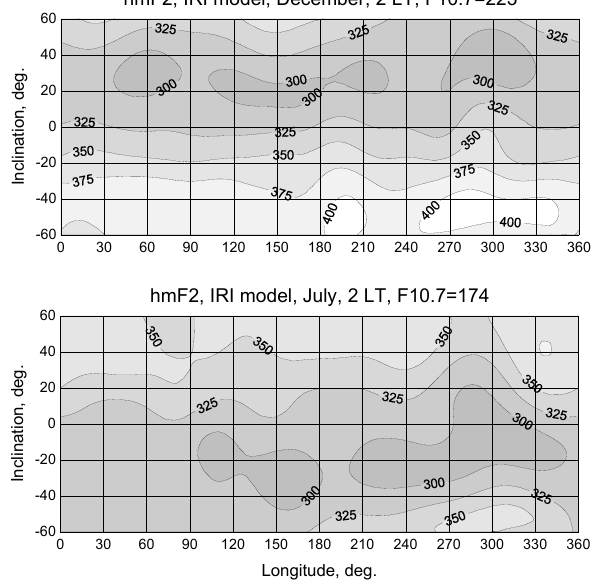
hmF2, IRI model, December, 2 LT, F10.7=223